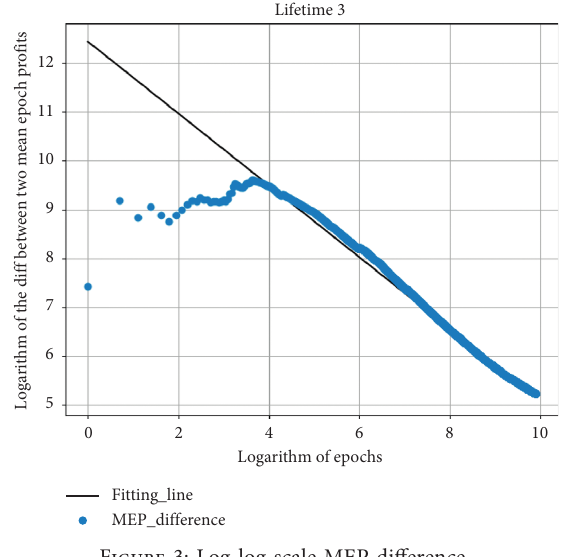
Figure 3: Log-log scale MEP difference.